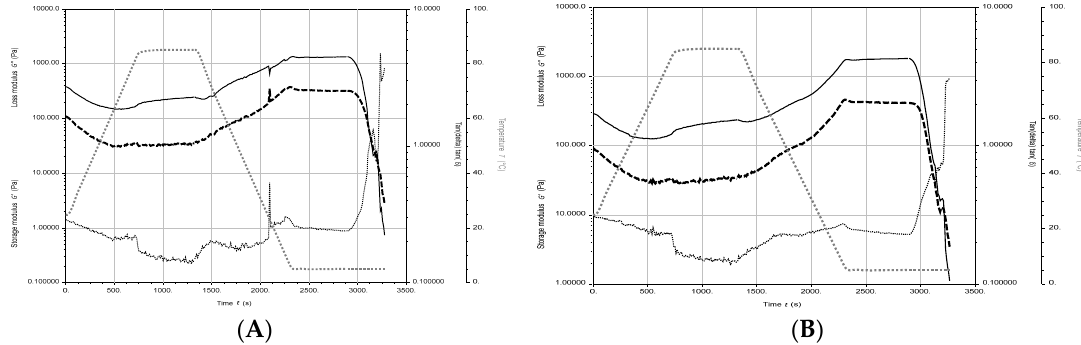
Figure A1. Dynamic moduli G’ and G” of cricket meals at 30% ( w / v ) and pH 7.0 during heating and cooling. ( A ) without NaCl addition and ( B ) with 1 M NaCl.